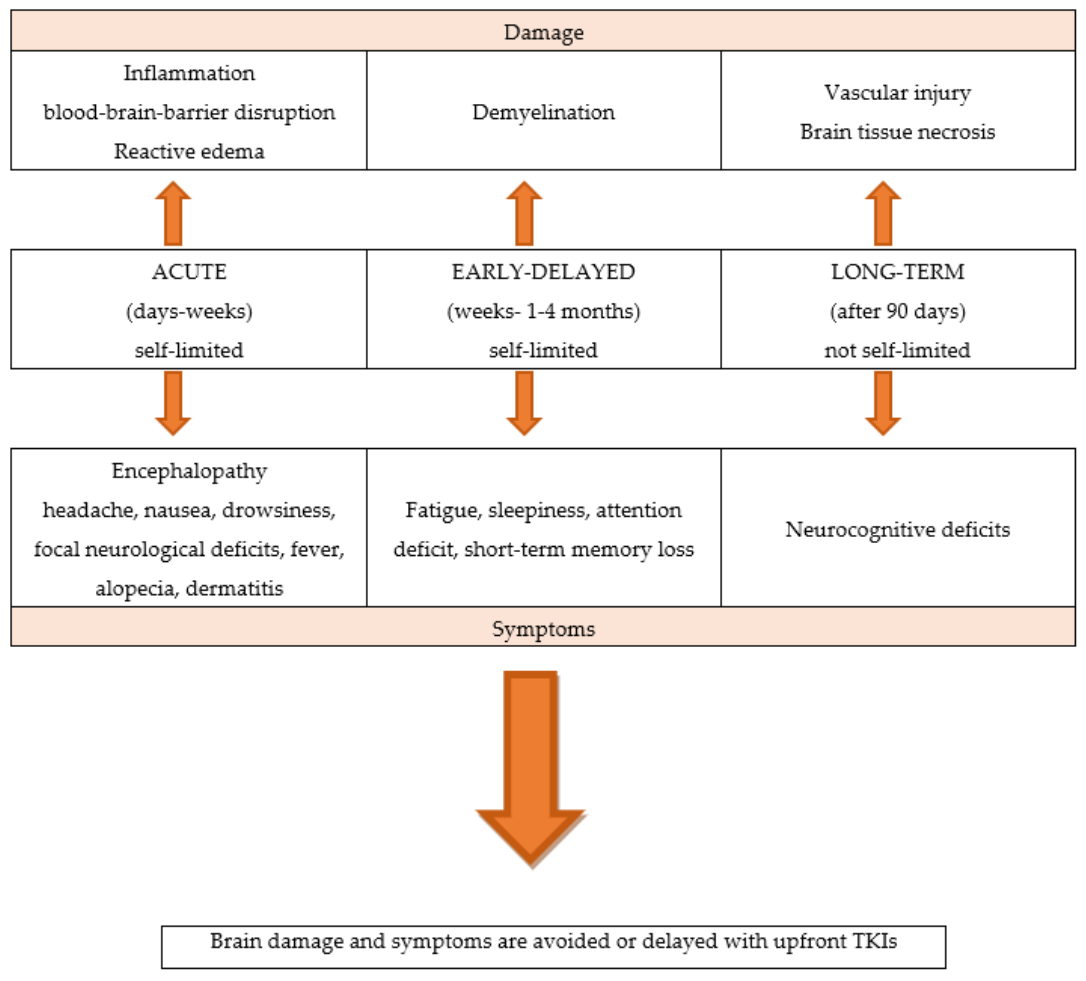
Figure 1. The neurological toxicities of brain